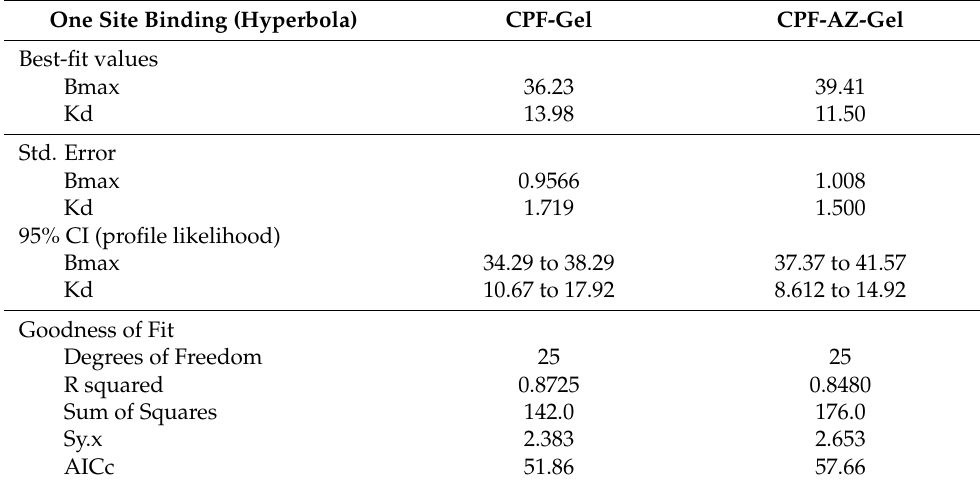
Table 4. Fitting and goodness of fit for the parameters estimated according to one-site hyperbola equations for the formulas CPF-gel and CPF-AZ-gel.